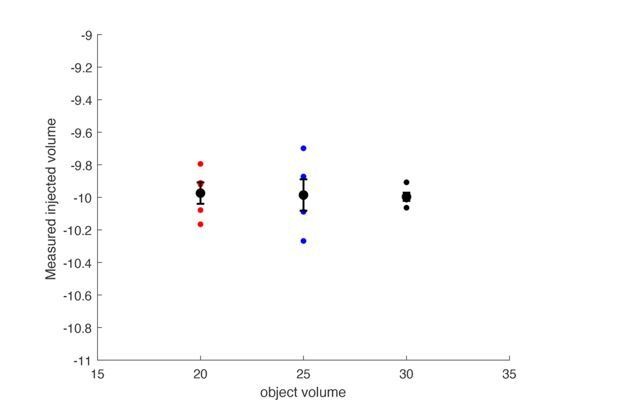
The plethysmograph was filled with either a 20, 25 or 30mL object to approximate a 20, 25, or 30 gram mouse.The plethysmograph was injected with 10mL of air and the change in pressure was integrated to calculate a tidal volume. The calculated tidal volumes were all centered at 10mL’s and the size of the object did not impact the calculated volume.